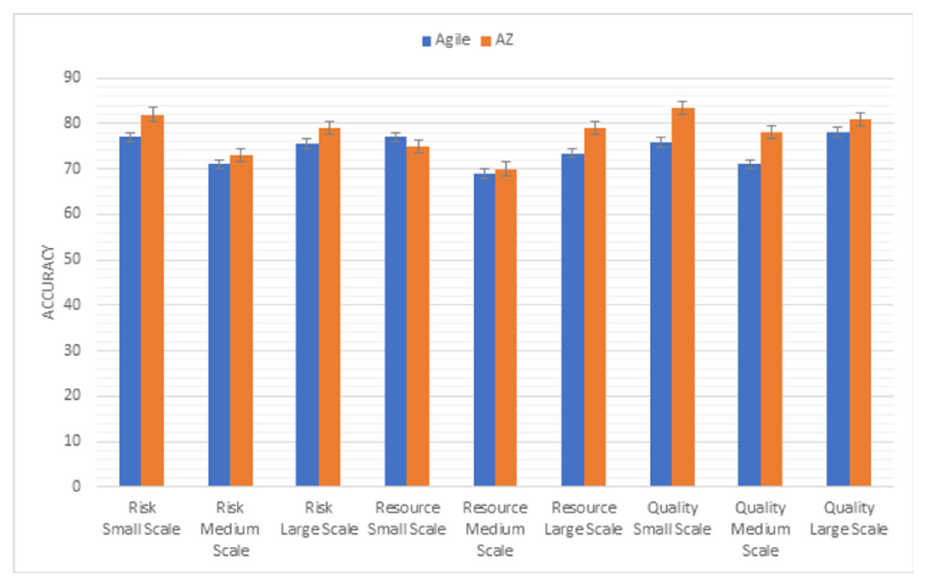
Fig 6. Graphical representation of agile vs AZ (second triangle) results.